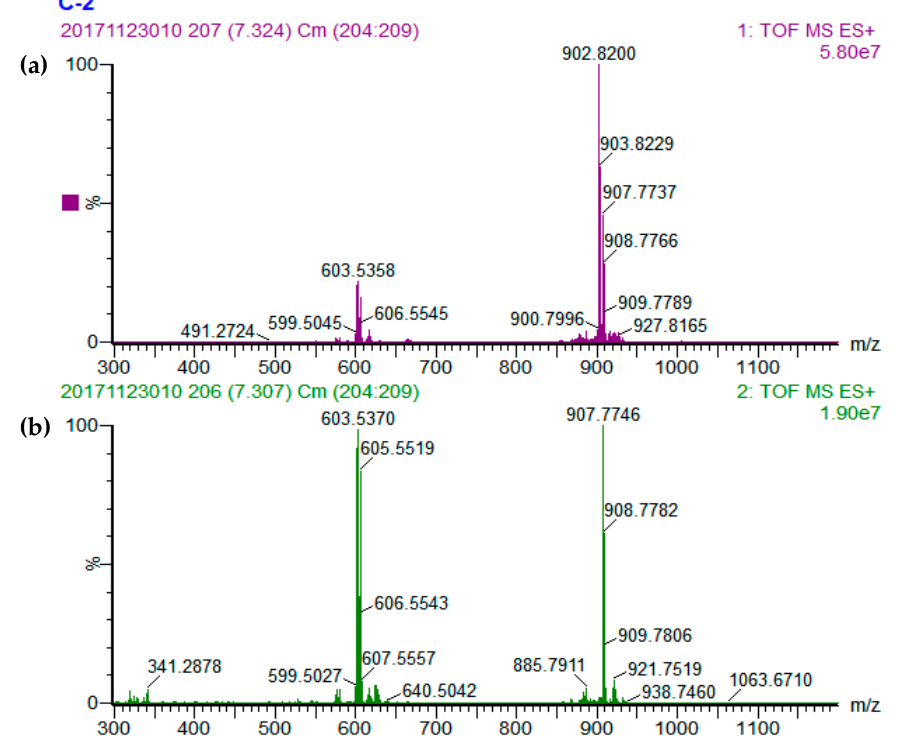
Figure 4. MS spectra of S-L-O. ( a ) MS 1 spectrum and ( b ) MS 2 spectrum.